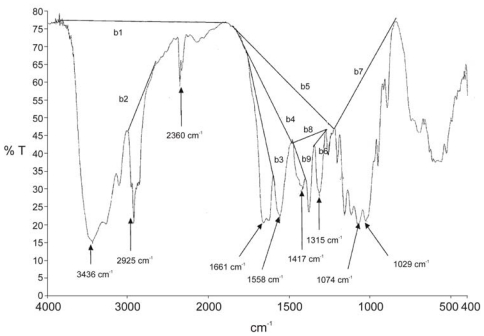
IR spectrum of chitin. Representation of the different baselines mentioned in the literature. Reprinted from Polymer 42, 2001, Brugnerotto, J., Lizardi, J., Goycoolea, F.M., Argüelles-Monal, W., Desbrières, J., Rinaudo, M., An infrared investigation in relation with chitin and chitosan characterization, 3569–3580, Copyright (2010), with permission from Elsevier [129].